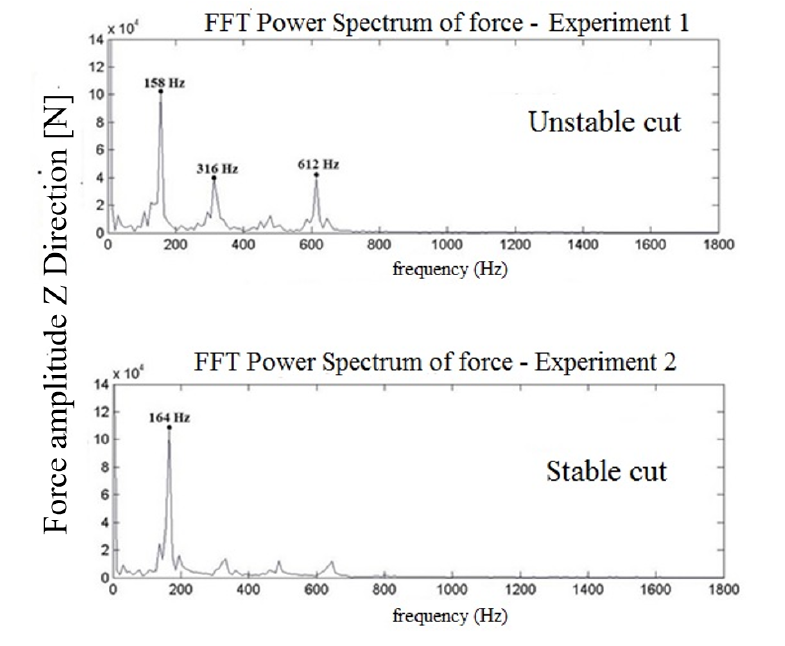
Fig. 6. FFT power spectrum of experiments 1, 2